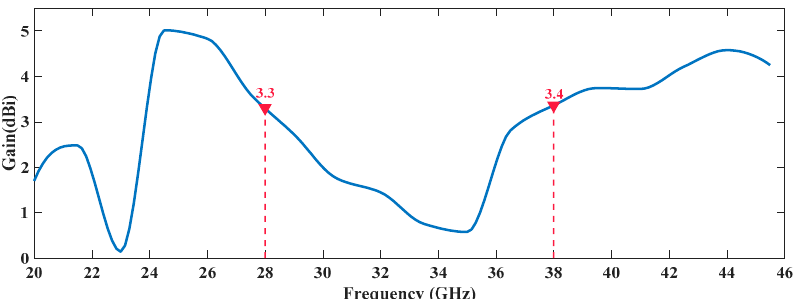
Sensors 2020 , 20 , x FOR PEER REVIEW Figure 13. Gain Variation Over Frequency of the Dual-Band Antenna. Figure 13. Gain Variation Over Frequency of the Dual-Band Antenna. Figure 13. Gain Variation Over Frequency of the Dual-Band Antenna.